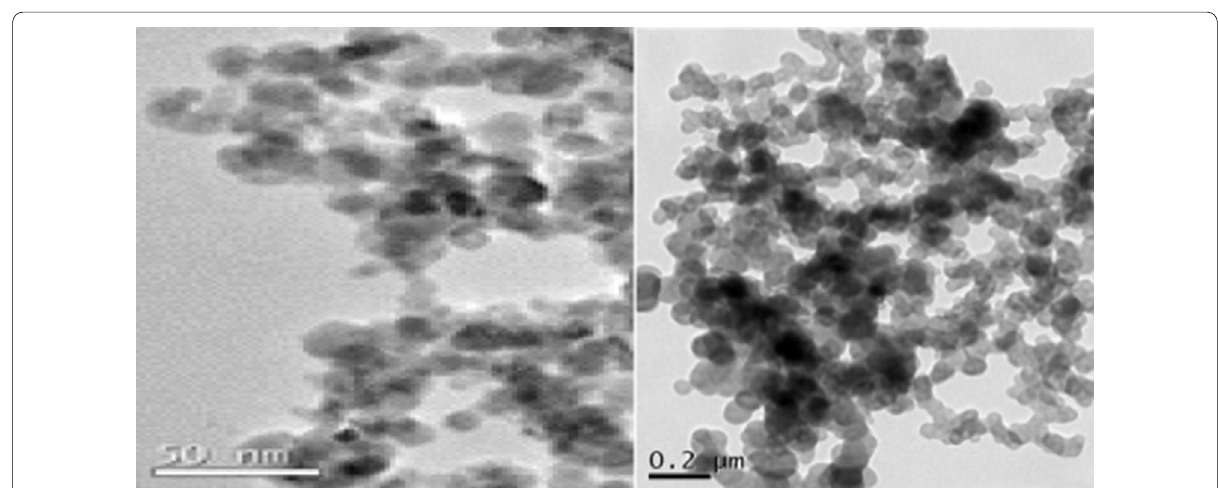
Fig. 4 TEM Ch-NPs—micrographs at 50- and 200-nm resolution